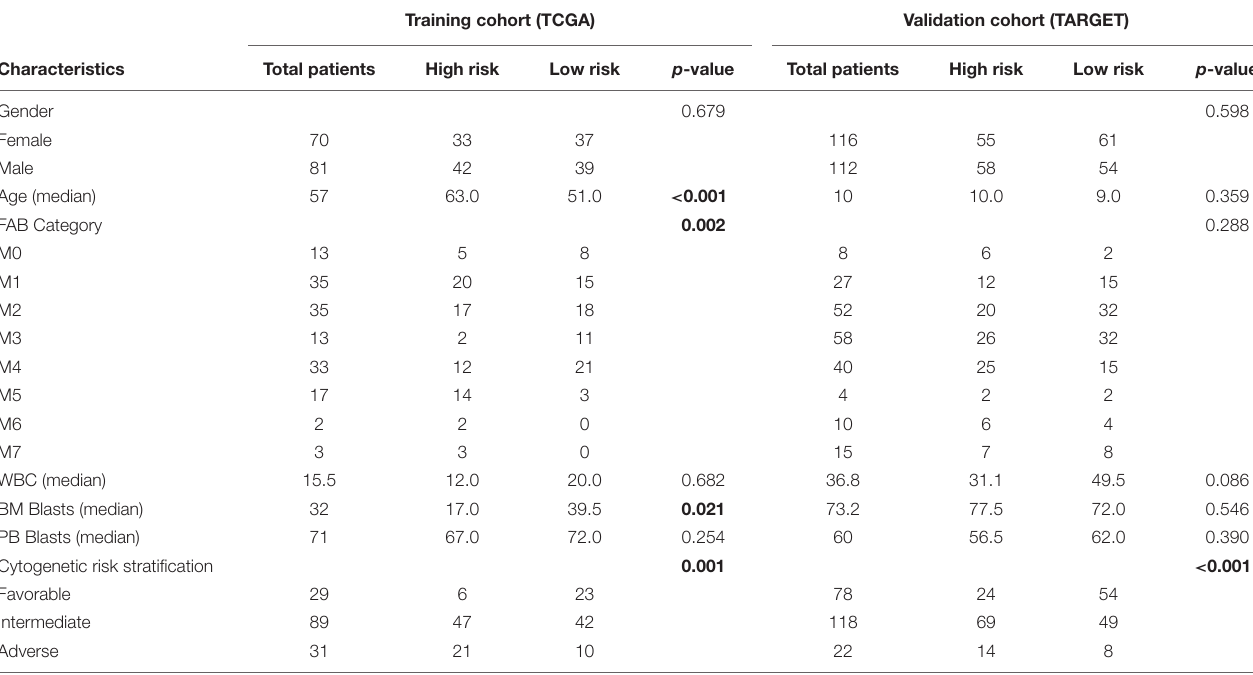
TABLE 1 | Correlation of clinicopathologic characteristics and the 12-gene signature in acute myeloid leukemia (AML).